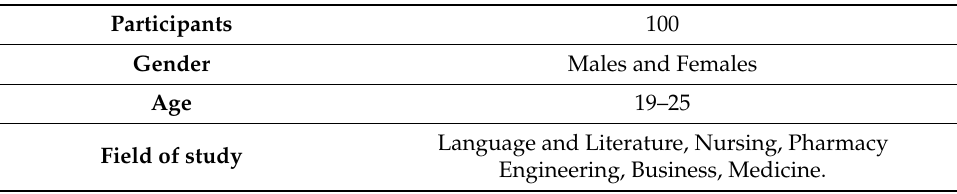
Table 1. Summary of the general characteristics of the participants. Participants 100 Gender Males and Females Age 19–25 Language and Literature, Nursing, Pharmacy Field of study Engineering, Business,